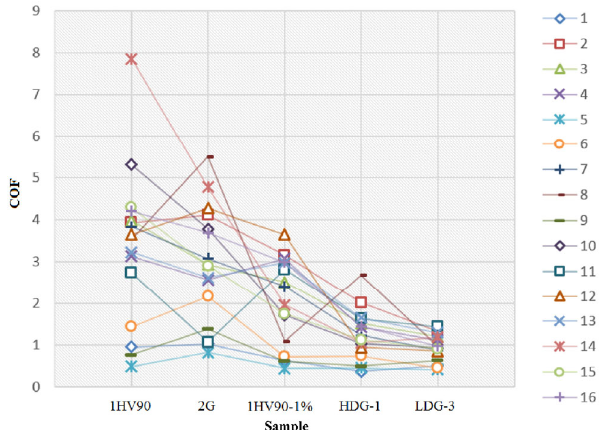
Fig. 5 Finger friction measurements of the participants on the stainless steel samples.